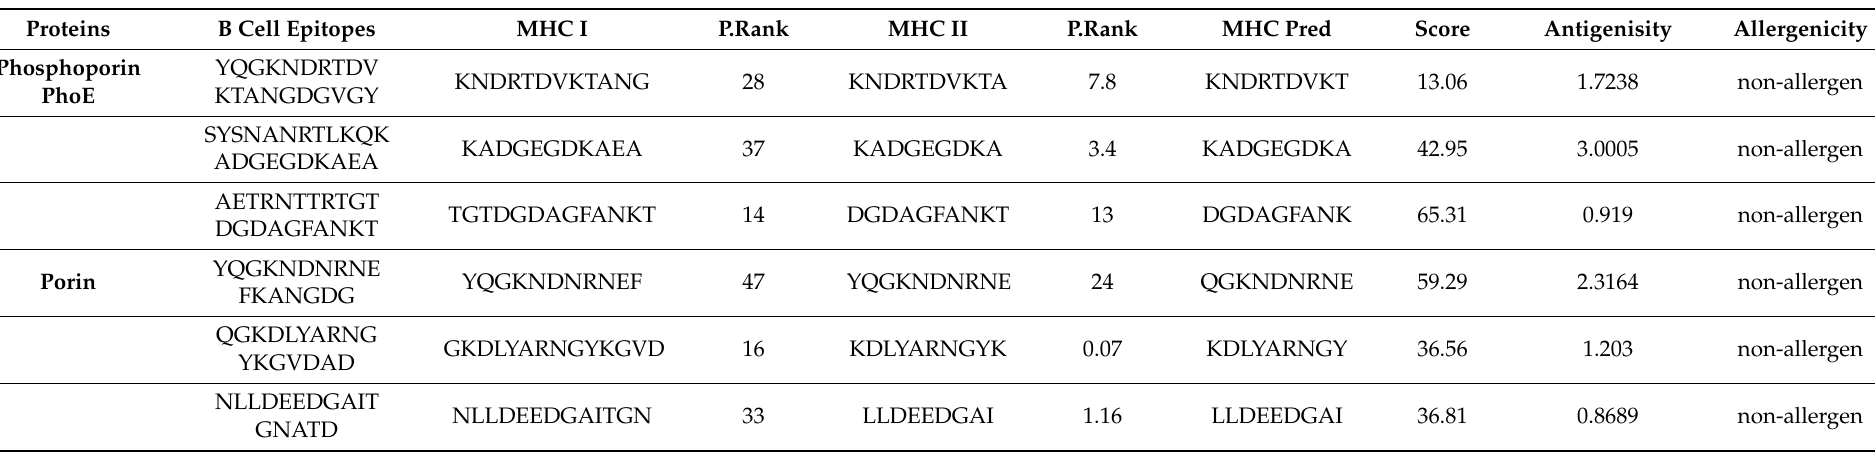
Table 2. Selection of the potent epitopes for the vaccine construct and the parameters for evaluation of the